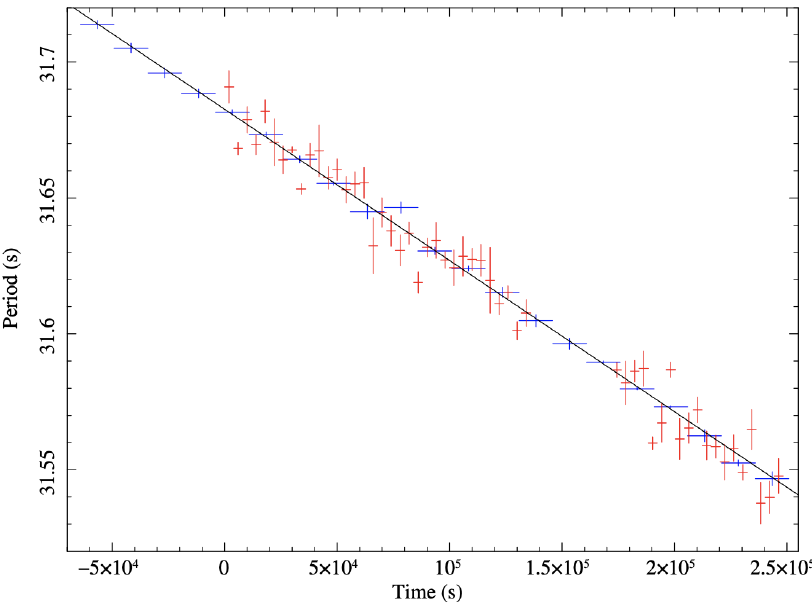
Figure 5. Figure 1 from Carpano et al. [28], showing the period evolution during the deep XMM-Newton / NuSTAR